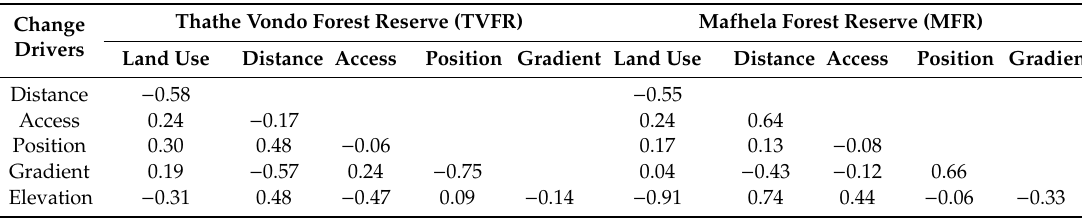
Table 2. Spearman correlation matrix of land use regimes and other environmental change